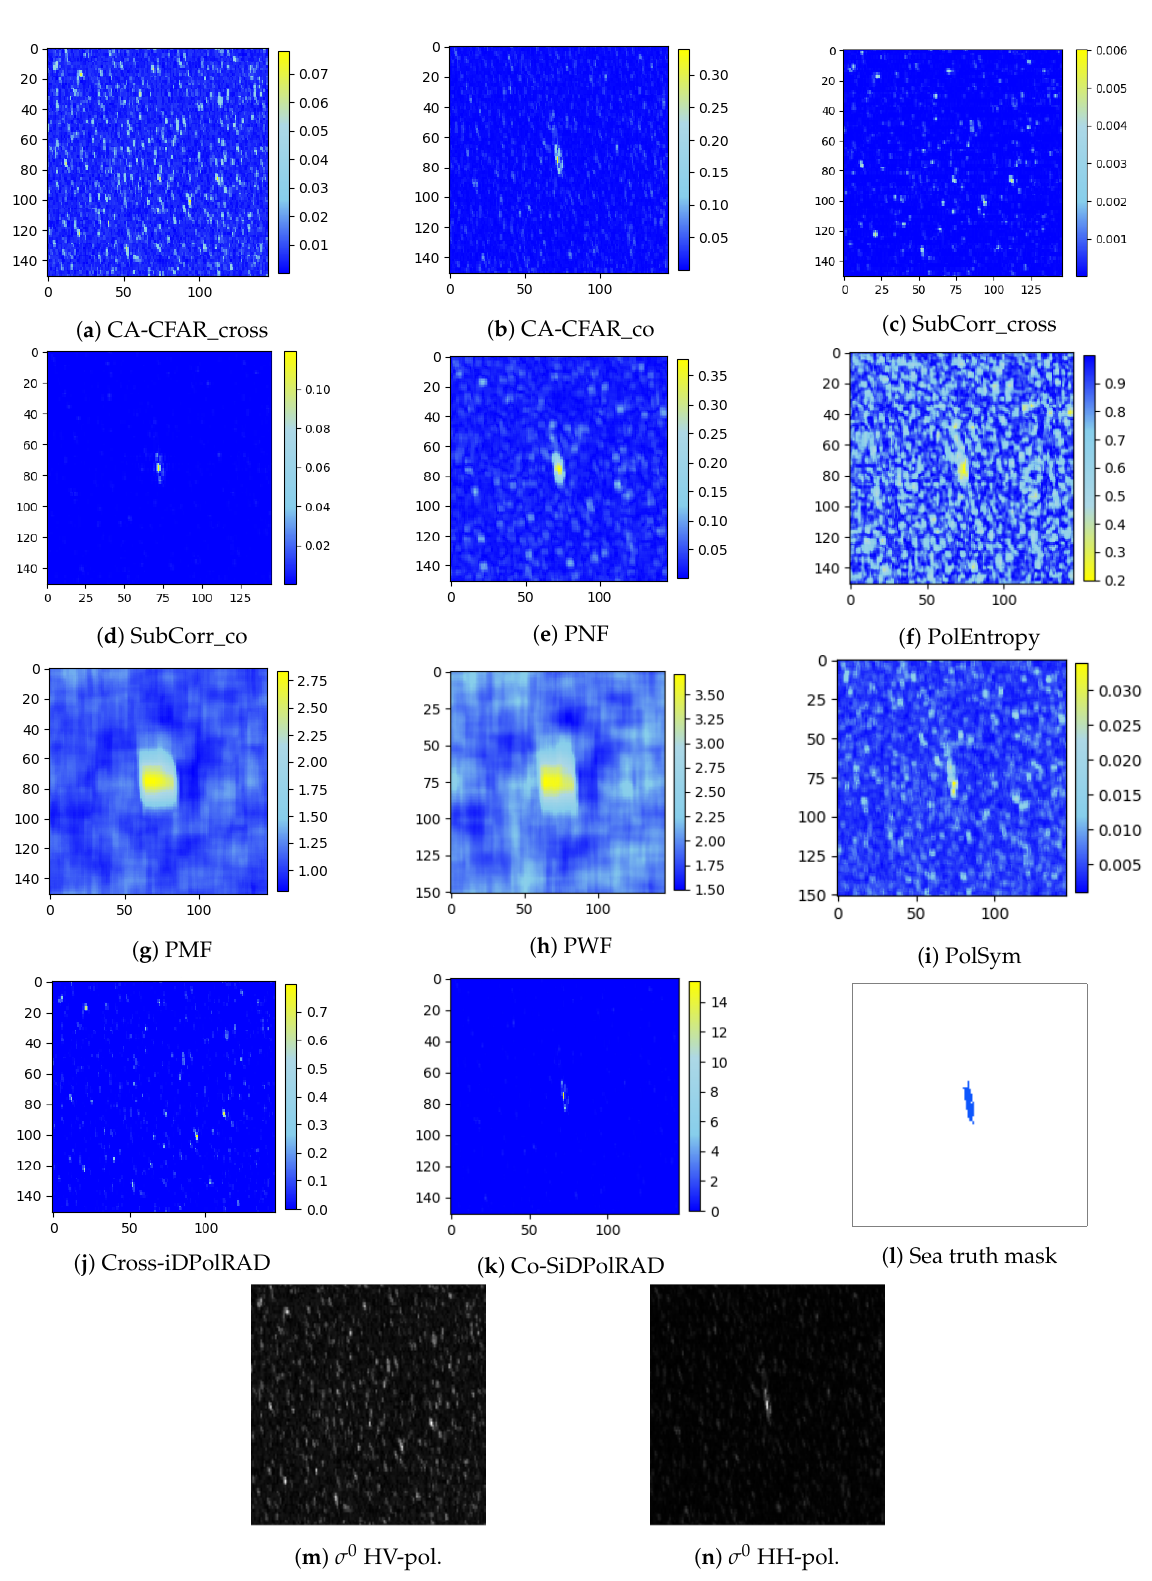
Figure 5. Incidence angle: high; boat: orthogonal, moving in azimuth; mode: SM; polarization: dual-pol HV and HH (scale in meters, colour ramps are without